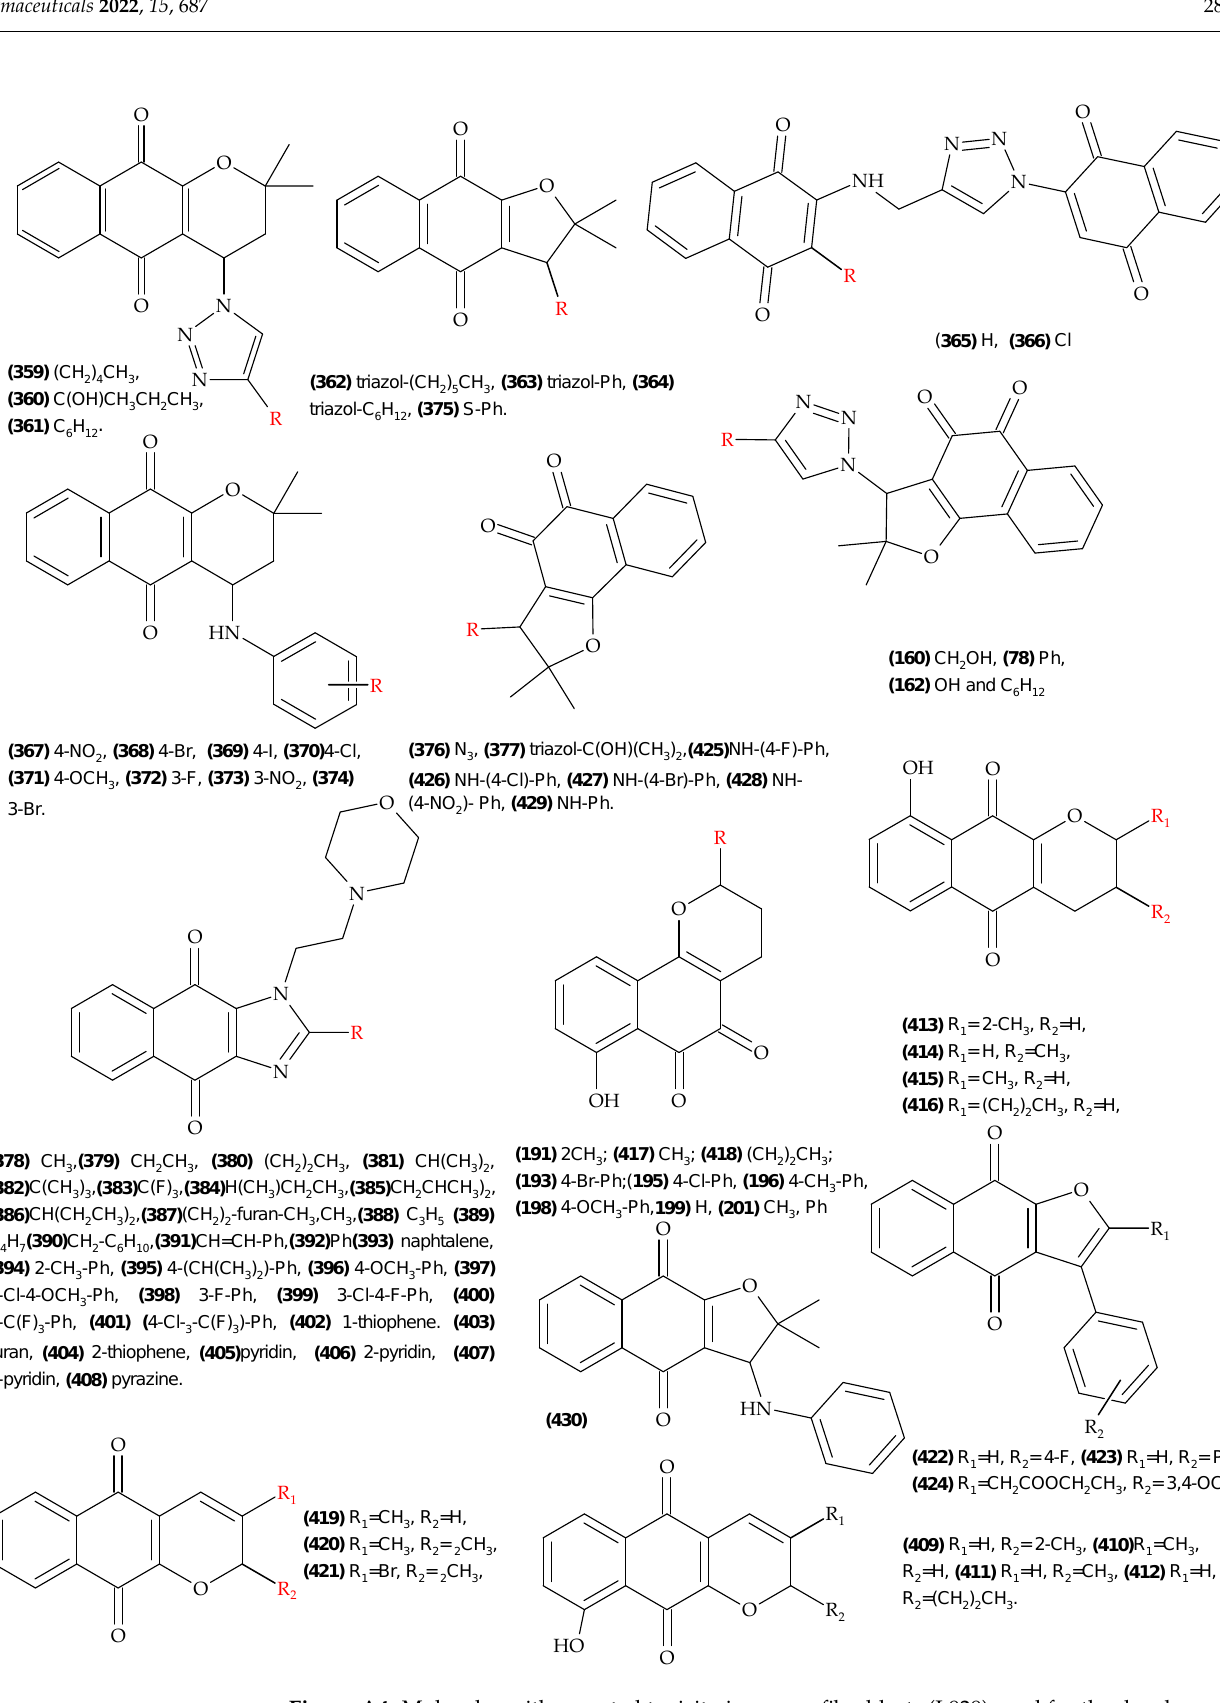
Figure A4. Molecules with reported toxicity in mouse fibroblasts (L929) used for the development of the QSAR model of toxicity.